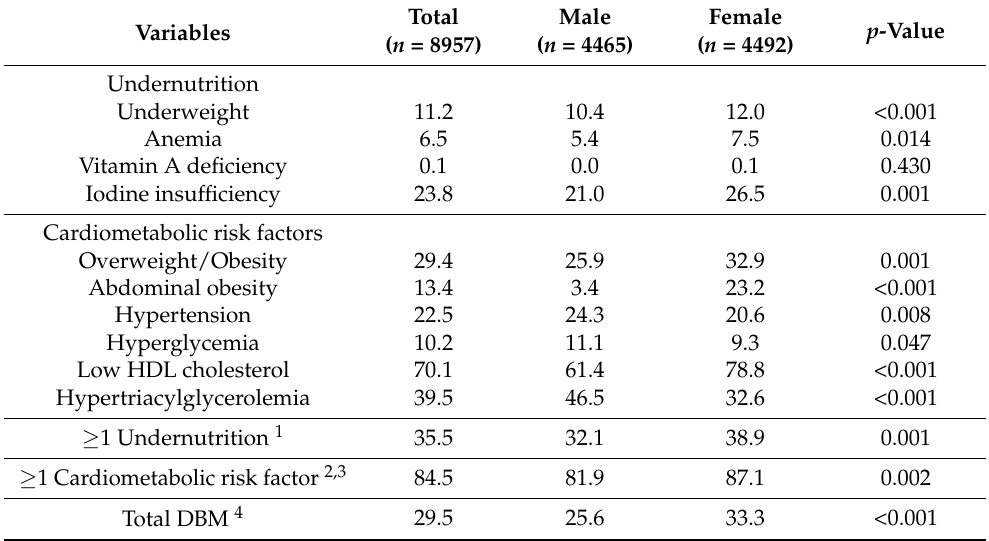
Table 2. Distributions of undernutrition, cardiometabolic risk factors, and double burden of malnutrition.